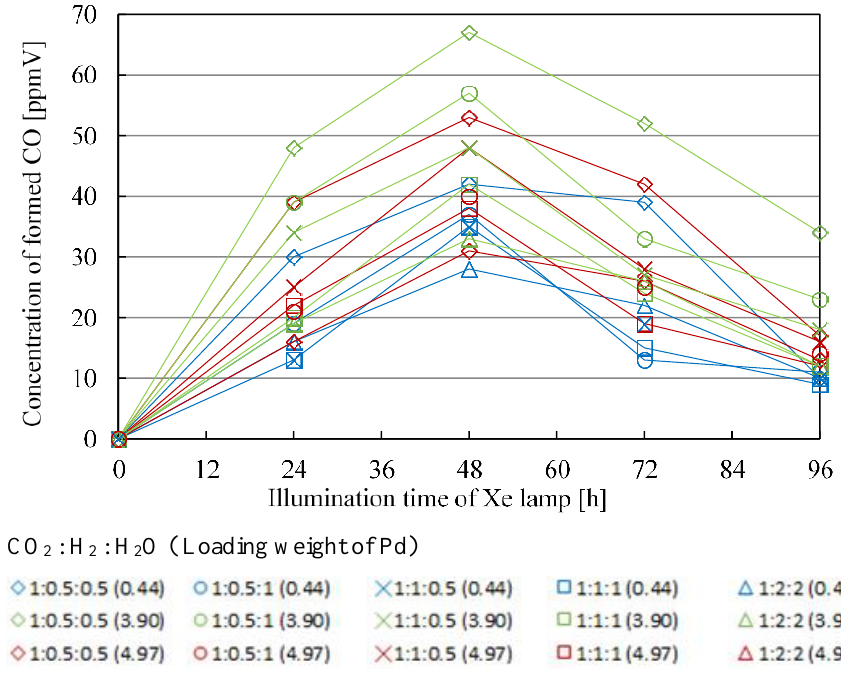
Figure 11. Change in concentration of formed CO with the illumination time among di ff erent molar ratios of CO 2 / H 2 / H 2 O and Pd loading weight without UV light illumination. Table 9. Comparison of maximum concentration of formed CO with illumination time among di ff erent molar ratios of CO 2 / H 2 / H 2 O and Pd loading weight without UV light illumination. 1:0.5:0.5